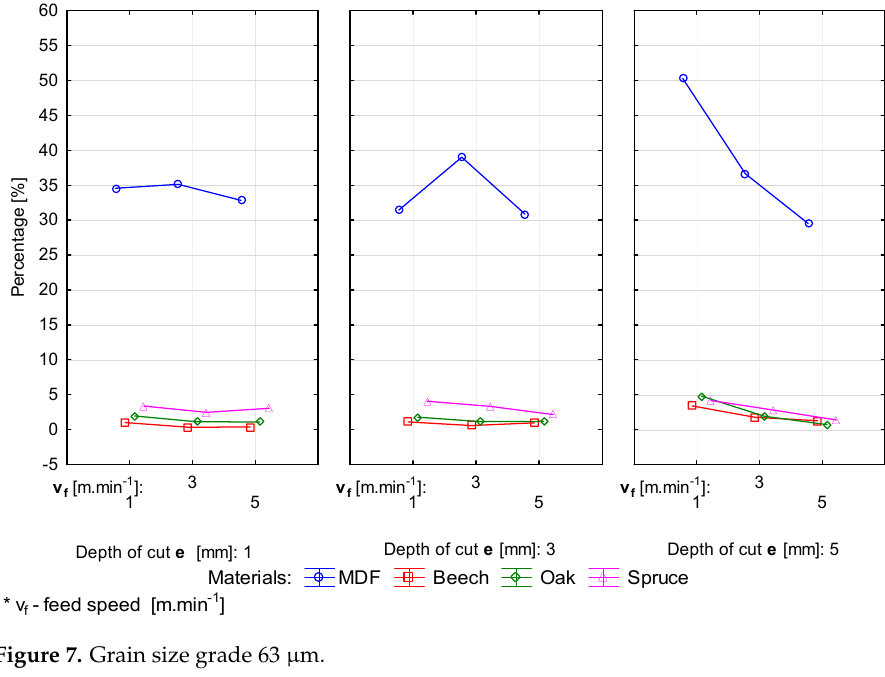
Figure 6. Grain size grade 125 μ m.